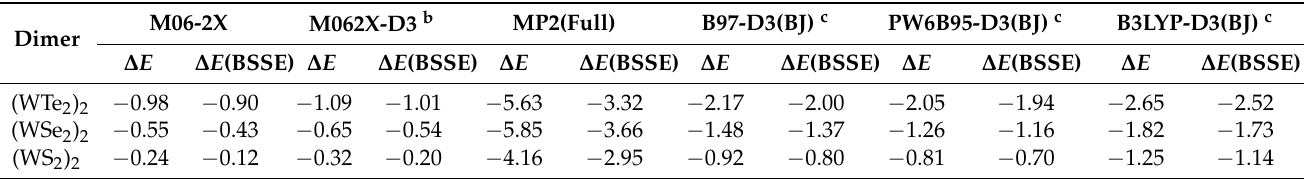
Table 2. Computed uncorrected and BSSE-corrected binding energies ( ∆ E and ∆ E (BSSE), respectively) of the (WCh 2 ) 2 (Ch = S, Se, Te) dimers, obtained with several methods in conjunction with the Aug- cc-pVTZ(-PP) basis set a